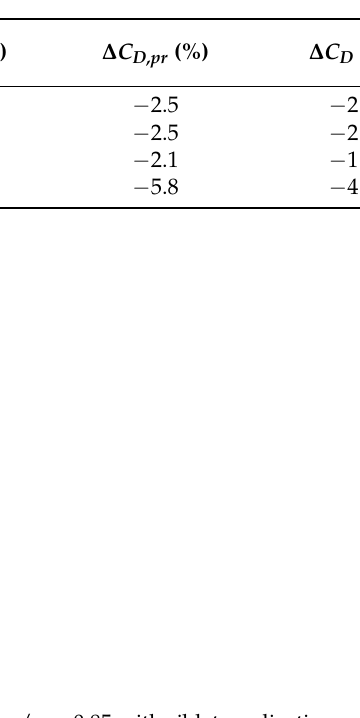
Table 4. Influence of riblet application on specific areas of the UAV at 0 ◦ AoA and loiter conditions.